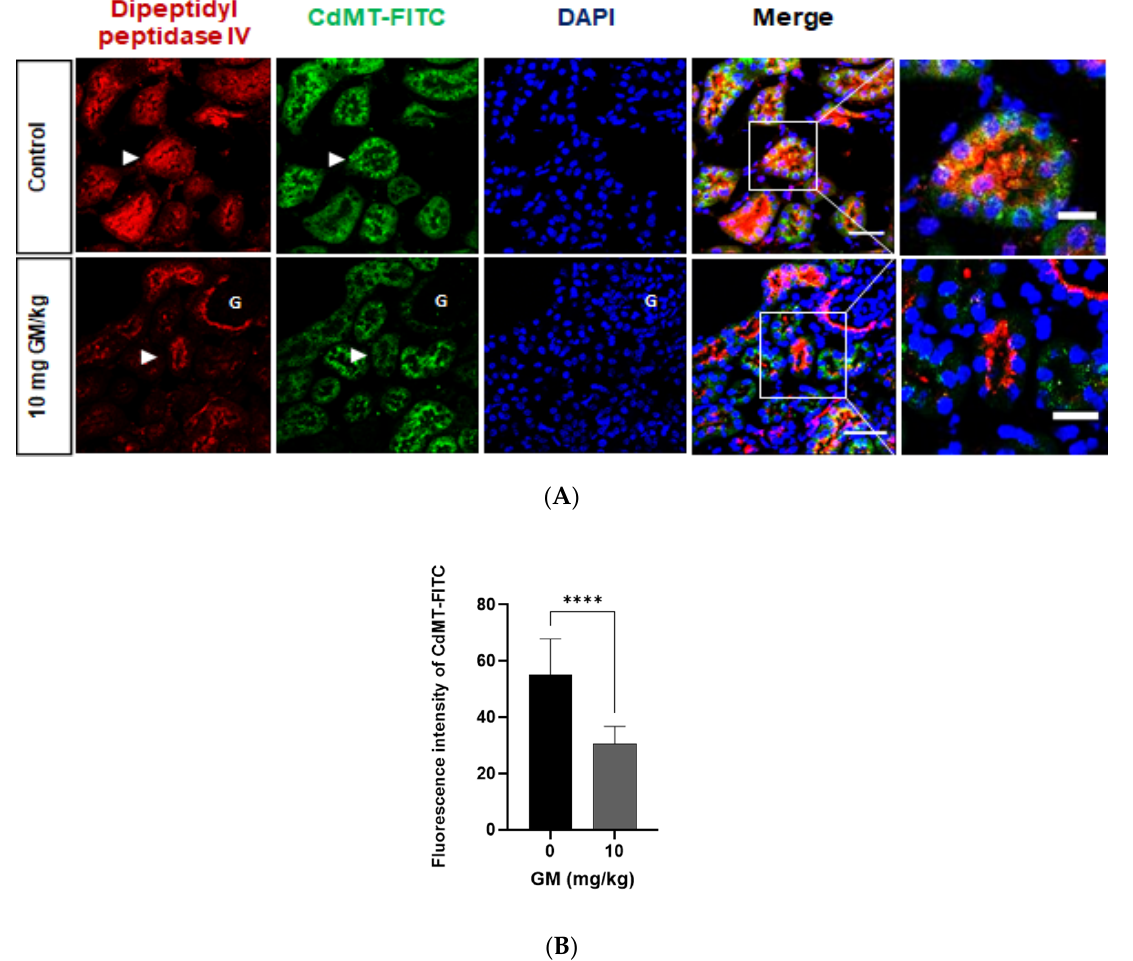
Figure 9. Uptake of CdMT by Dipeptidyl Peptidase IV (DPPIV) positive PT cells decrease after GM administration. ( A ) Representative micrographs of CdMT complex immunofluorescence intensity (green) with stained DPPIV (red) and nuclei (blue DAPI). Scale Bars = 50 µm ( left ) and 20 µm ( right ). G: glomerulus. White arrowheads point at magnified tubules in the merged images of control and GM treated animals. ( B ) Quantification of CdMT complex immunofluorescence intensity in DPPIV positive cells (PT). The bar graph displays means ± SD of five randomized photographs per animal (three animals per group). Student’s t -test was performed, **** p < 0.0001.